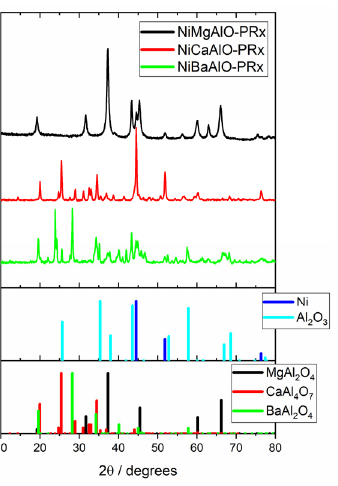
Figure 7. XRD Diffractograms of NiBaAlO-PRx, NiMgAlO-PRx, and NiCaAlO-PRx samples, where main phases detected have been indicated (JCPDS: Ni = 01-087-0712; Al 2 O 3 = 00-042-1468, MgAl 2 O 4 = 00-001-157, CaAl 2 O 4 =